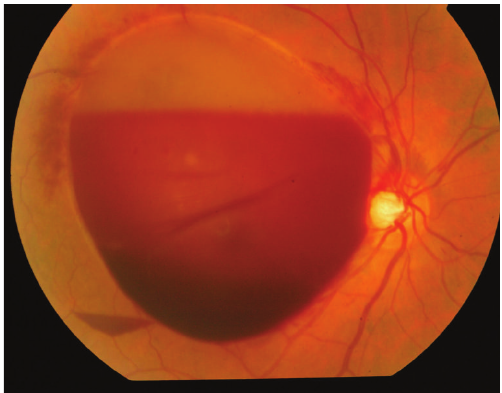
Figure 1: Massive subinternal limiting membrane (ILM) hemor- rhage secondary to Valsalva maneuver.